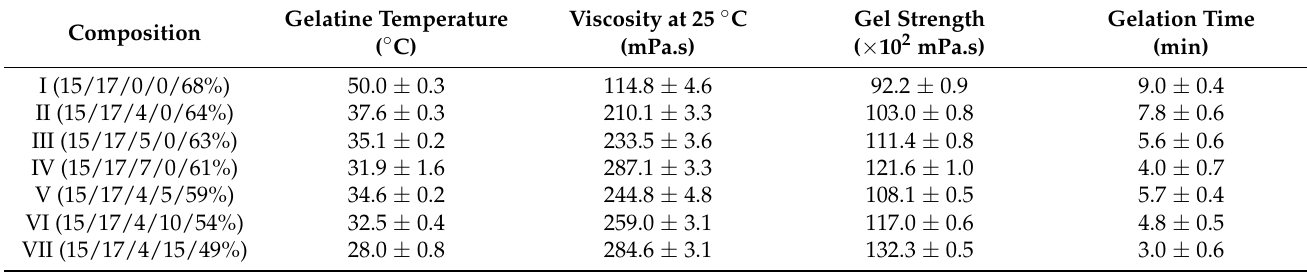
Table 1. Gel properties of irinotecan-loaded